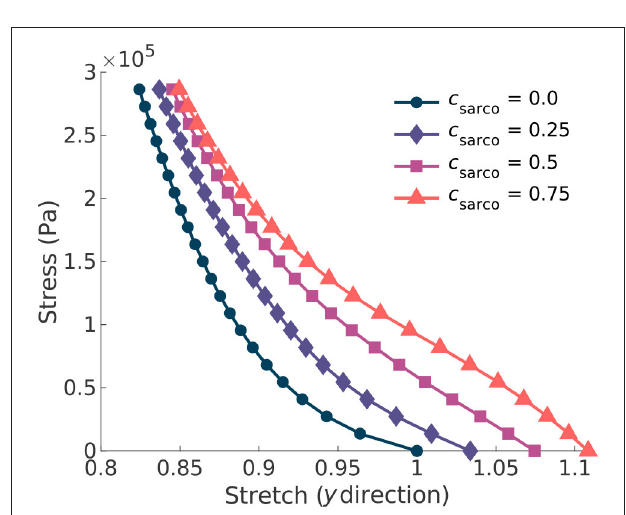
FIGURE 4 | Plot of the normal stress applied in the along-fibre direction ( x ) against the stretch in the muscle transverse to the fibres. Given the symmetry in the muscle geometry transverse to the fibres ( y ), the stress-stretch response shown is the same in the z direction. Each line represents a shift in the sarcomere stretch by a factor of c sarco